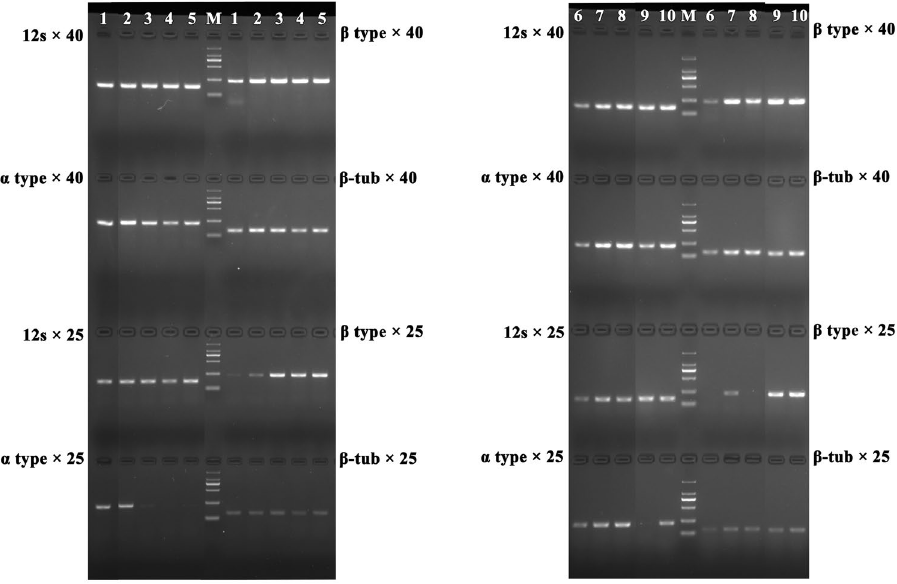
Figure 5. The semi-quantitative results of four genes. Sample number: 1 = KY7-11, 2 = GB192, 3 = KY7-21, 4 = JN1-13, 5 = SL3-13, 6 = XY18-9, 7 = GB073, 8 = GB171, 9 = XY18-2, 10 = GB020. According to the results of genotyping, lanes 1, 2, 6, 7 and 8 had “ α ” type fragment as the primary component, while the remaining samples (3, 4, 5, 9 and 10) had “ β ” type fragment as the primary component. The amplicon genotype and cycle numbers are indicated on either side of the gels. M: Marker ladder